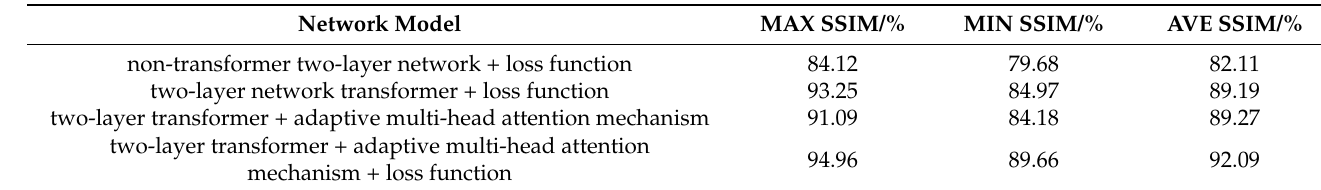
Table 4. Comparison of SSIM metric for ablation